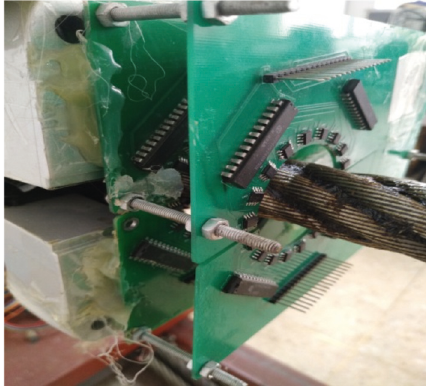
Figure 3: Double detection